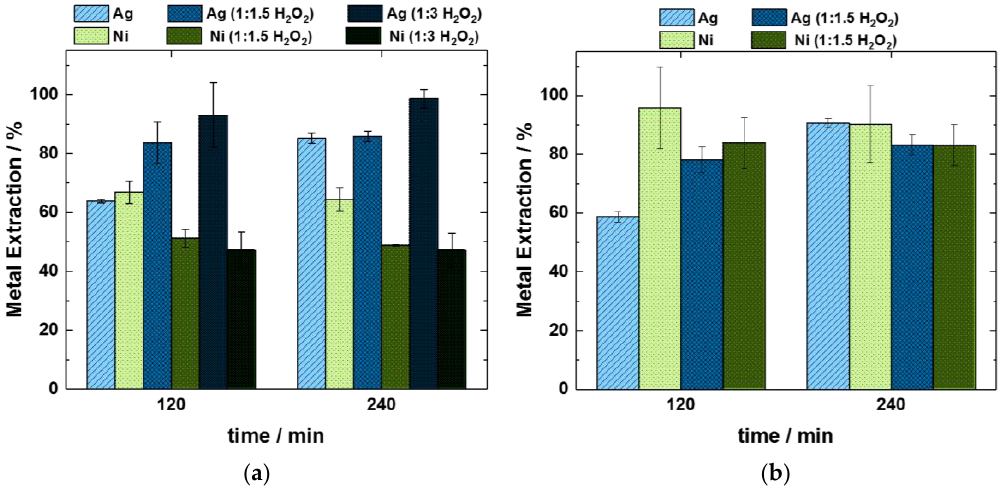
Figure 4. Recovery rate for silver and nickel for leaching trials with ( a ) 5% HNO 3 and ( b ) 10% HNO 3